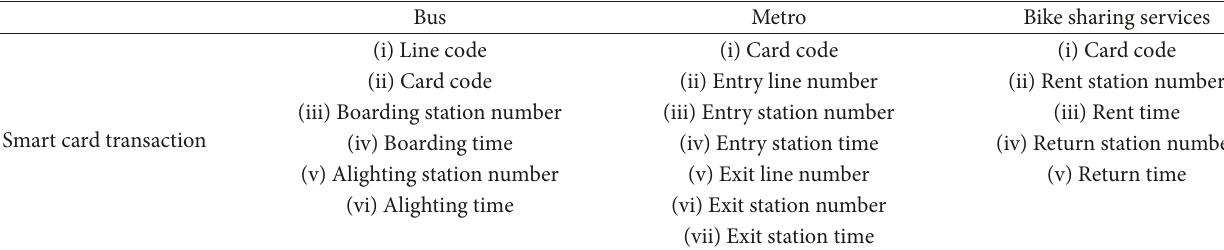
Table 1: Effective fields of public transport smart card transaction data.